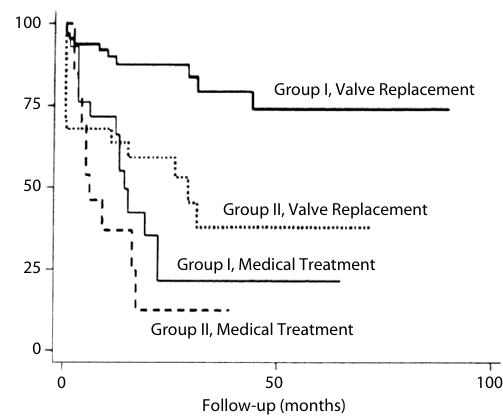
Figure.3 SurvivalforlowgradientlowEFASpatientsisplottedaccordingtheinotropicreserve.GroupIpatients with inotropic reserve fared better than patients without inotropic reserve and also had a better outcome with aortic valve replacement than with medical therapy. Taken from Ref. [35] with